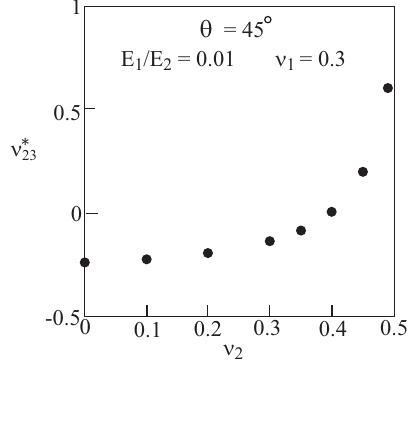
Figure 7. Re-entrant array ( θ = 45 ◦ ) with two distinct materials. Variation of the effective Poisson’s ratio ν ∗ with the Poisson’s ratio of material 2 while keeping its Young’s 23 modulus constant.